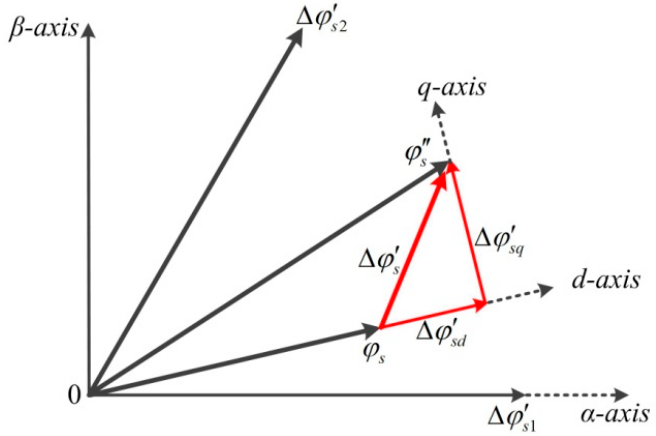
Figure 5. Analysis of error compensational effects.